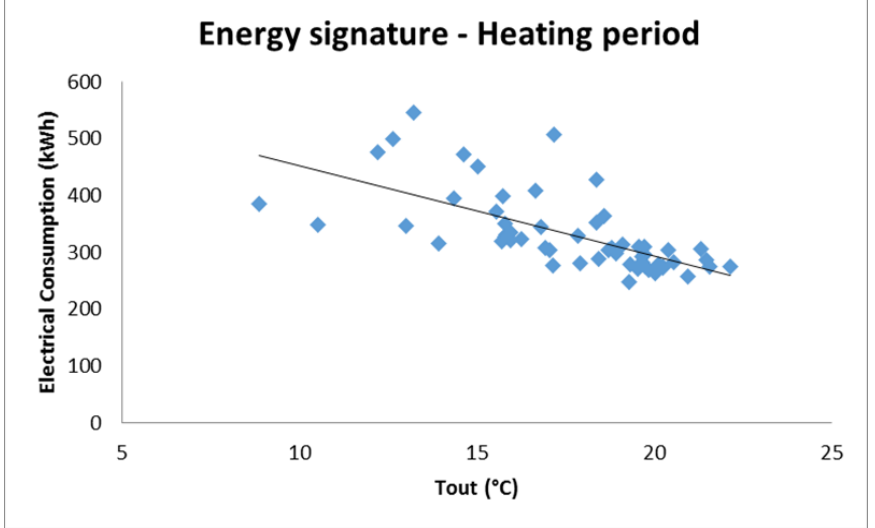
Figure 11. Energy signature of the B FEPA building for the heating period (November 2018–January